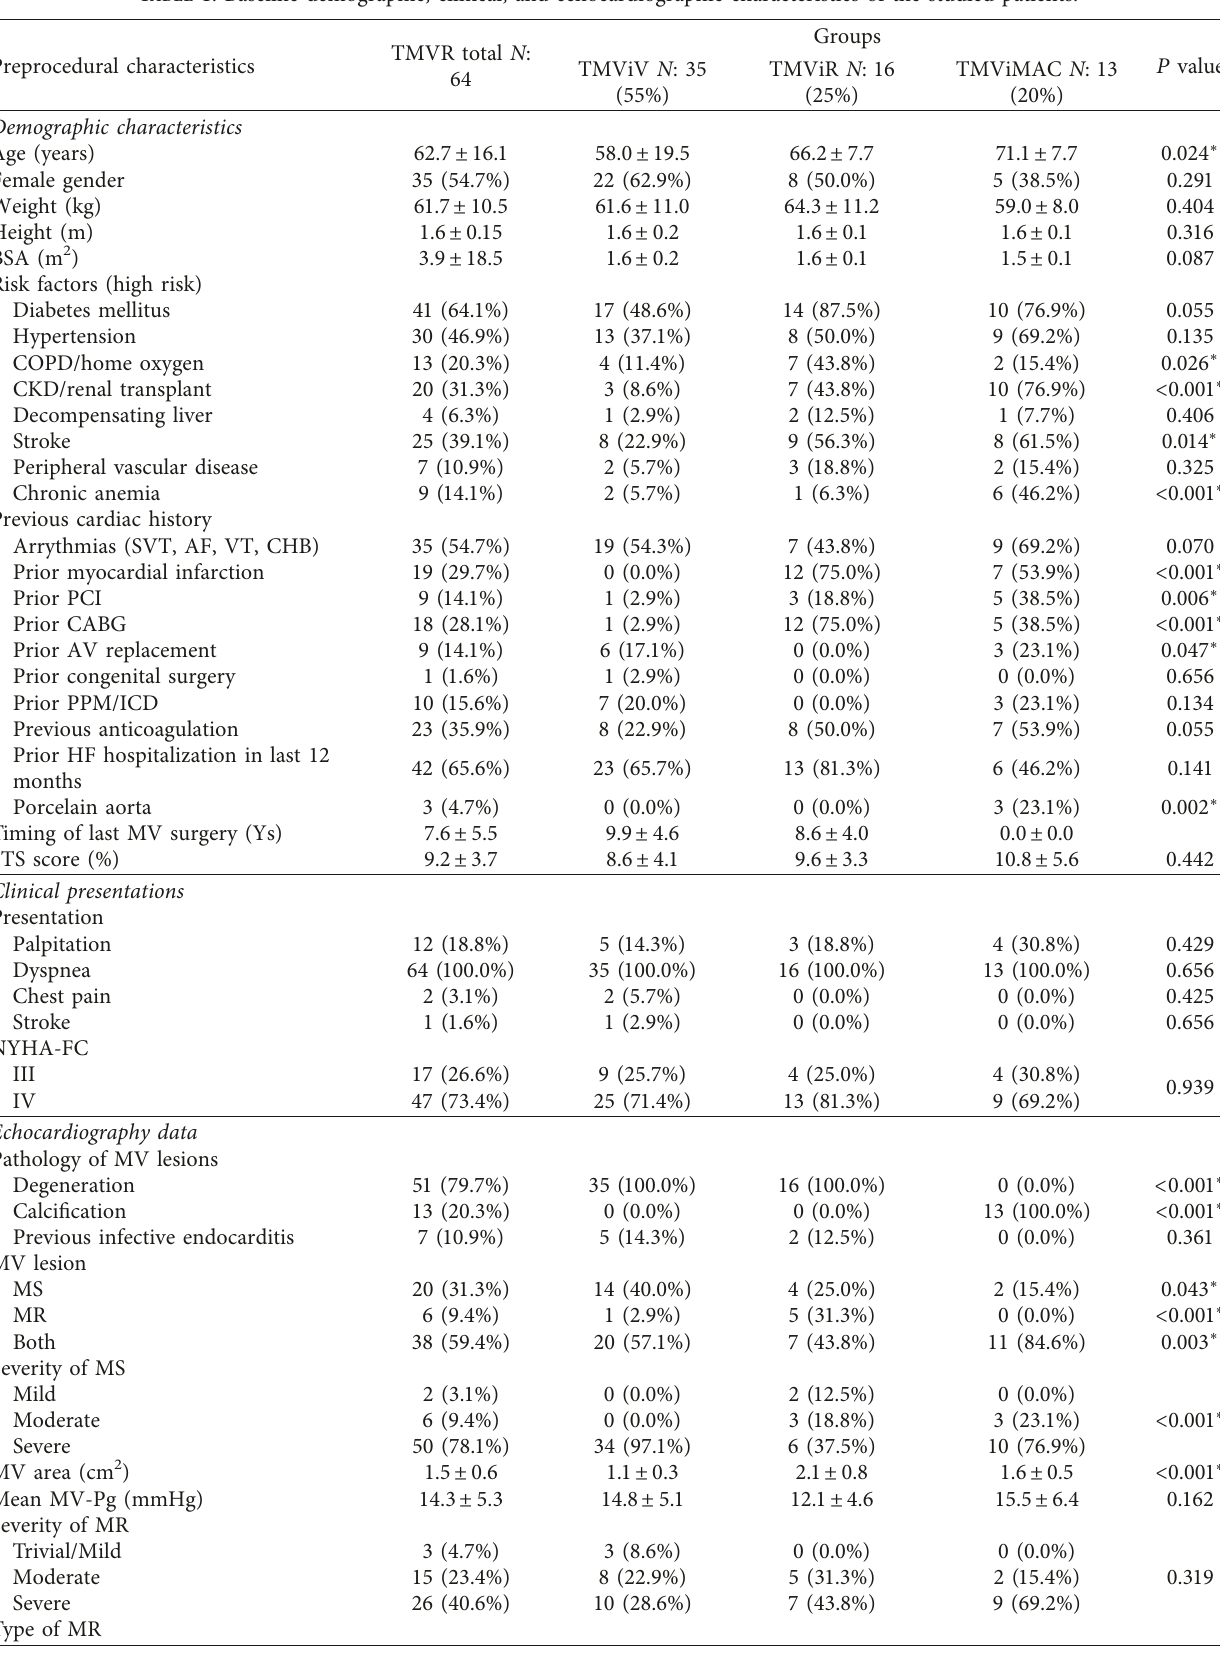
Table 1: Baseline demographic, clinical, and echocardiographic characteristics of the studied